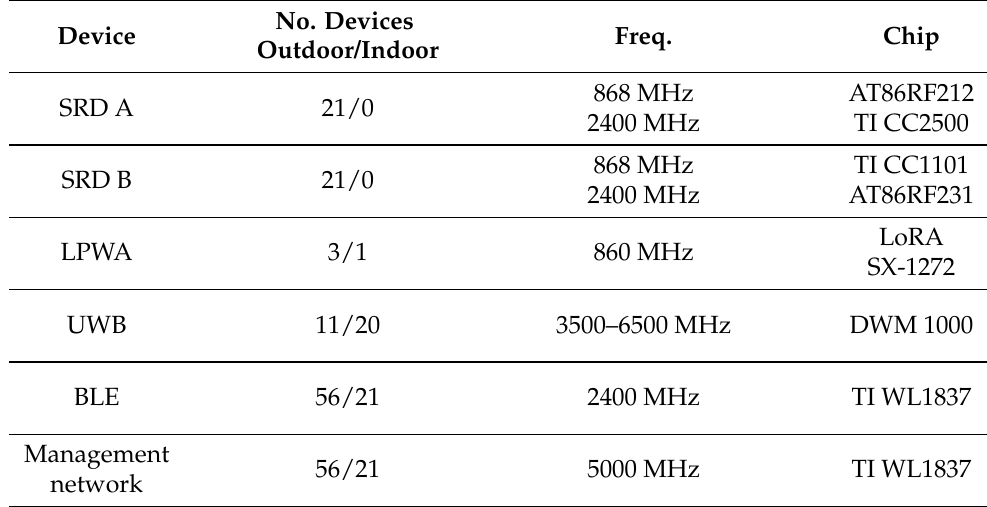
Table 1. Wireless technologies deployed on testbed